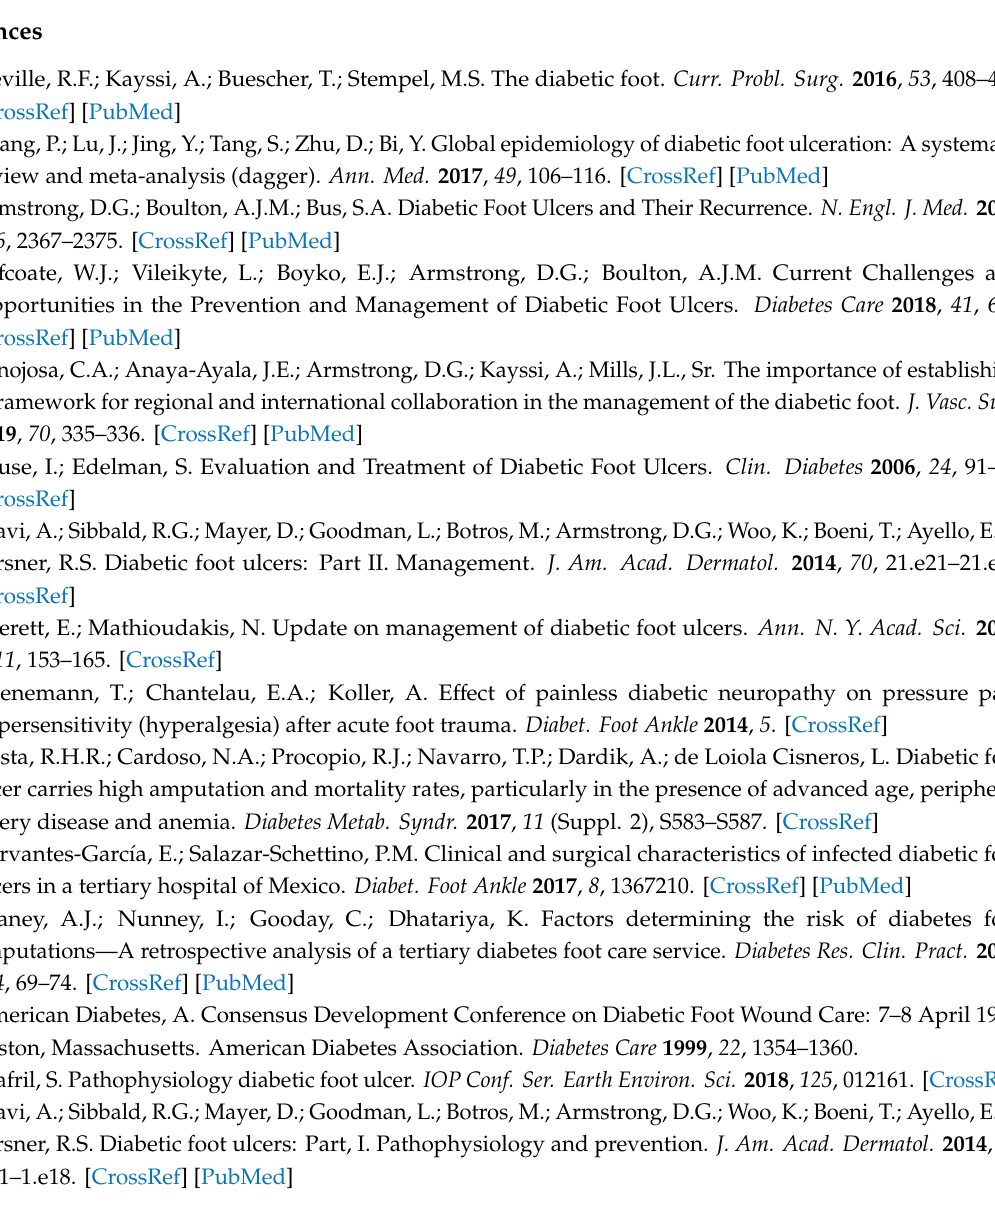
Table S1: Conventional antibiotic therapies according to the DFU infection